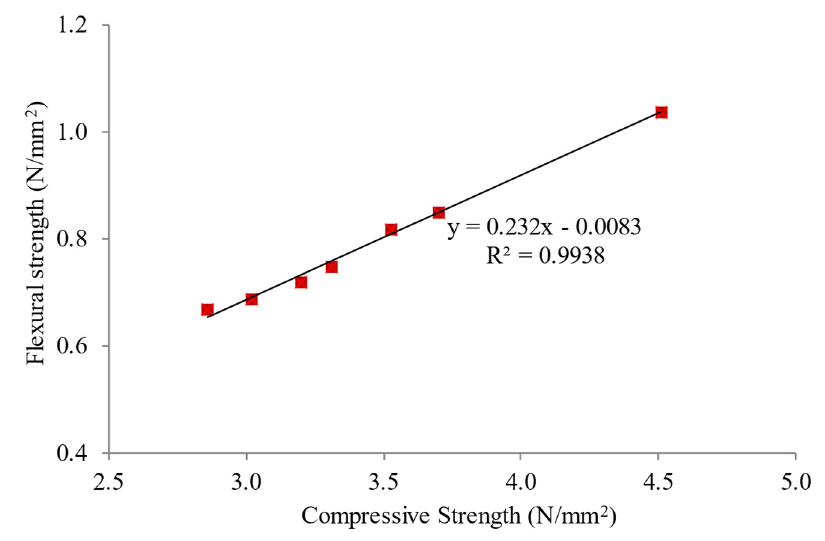
Figure 13. Relationship between compressive and flexural strengths of LFC.